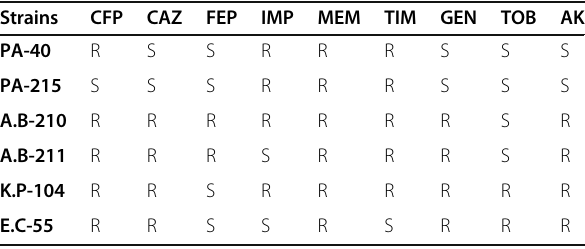
Table 1 Antibiotic profile of test